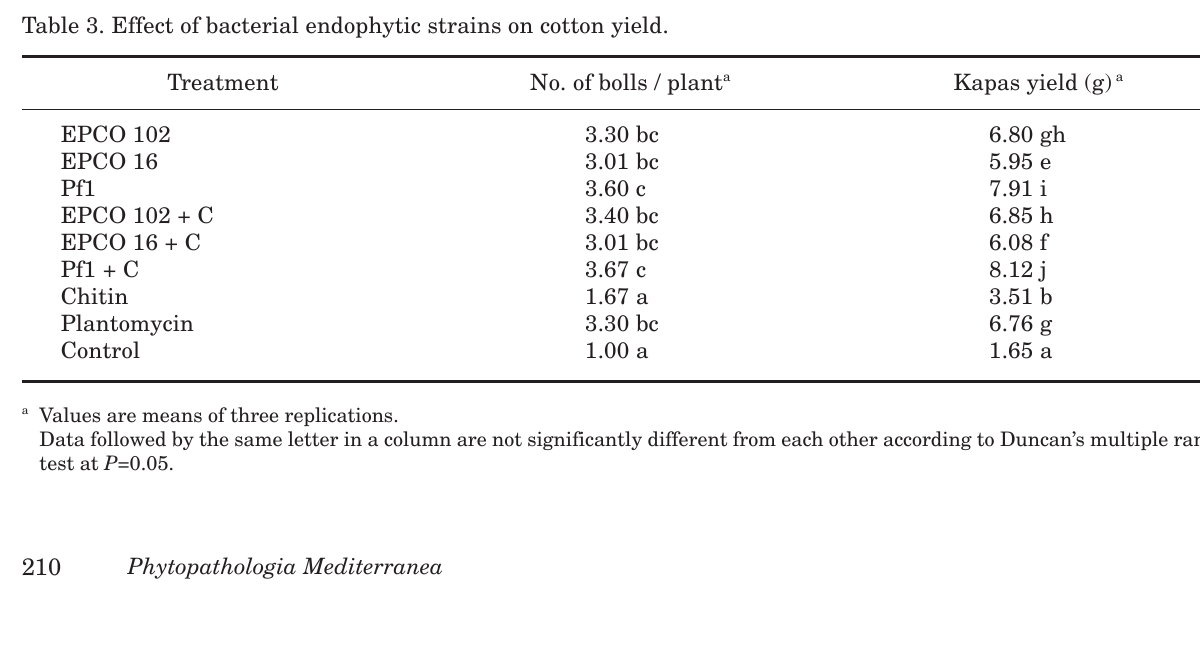
Fig. 2. Native PAGE of peroxidase in cotton plants treat- ed with endophytic bacterial strains against Xan- thomonas axonopodis pv. malvacearum ( Xam).